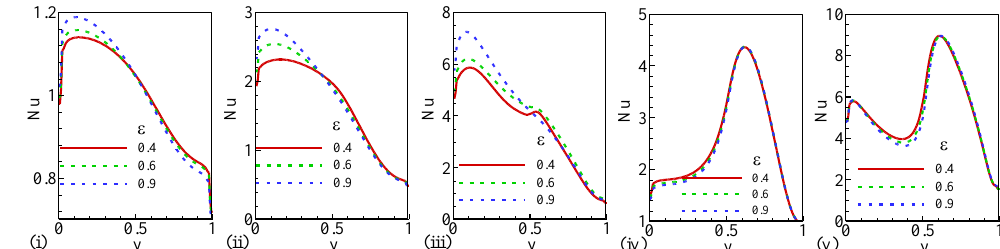
Fig. 8 (a). Influence of porosity parameters on Nu , of horizontal porous layer at (i) Ra =10 3 , Da =10 -2 , (ii) Ra =10 4 , Da =10 -2 . (iii) Ra =10 5 , Da =10 -2 , (iv) Ra =10 5 , Da =10 -4 and (v) Ra =10 6 , Da =10 -4 .